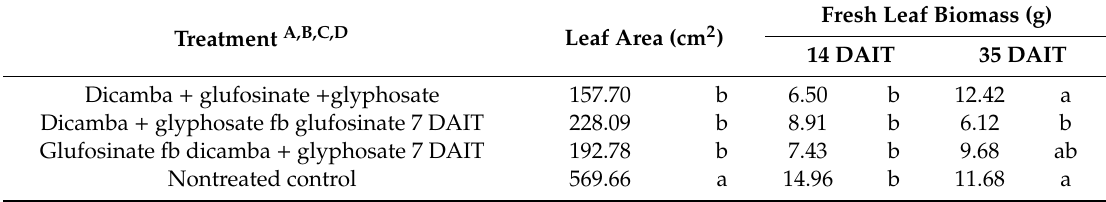
Fresh Leaf Biomass (g) 14 DAIT 35 DAIT